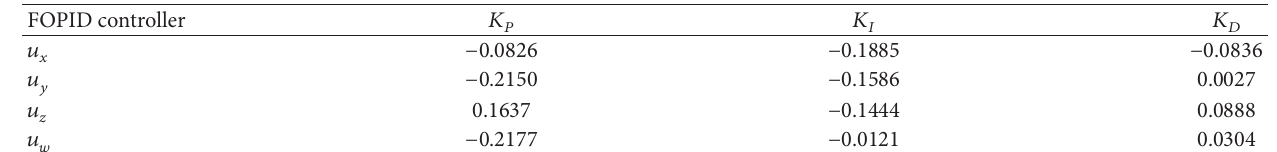
Table 2: FOPID controller gain values optimized with GA.